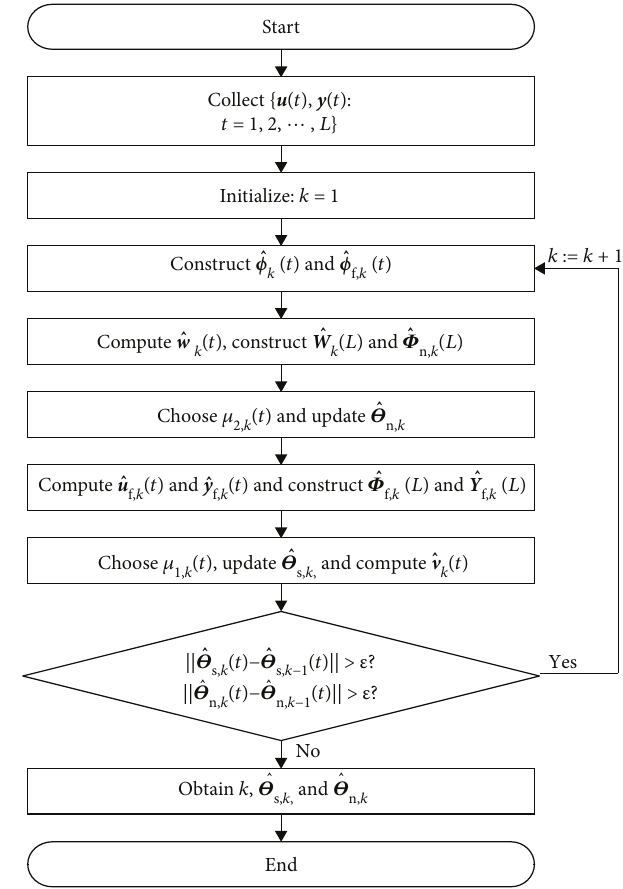
Figure 3: The fl owchart of computing the F-GI parameter estimates with fi nite measurement